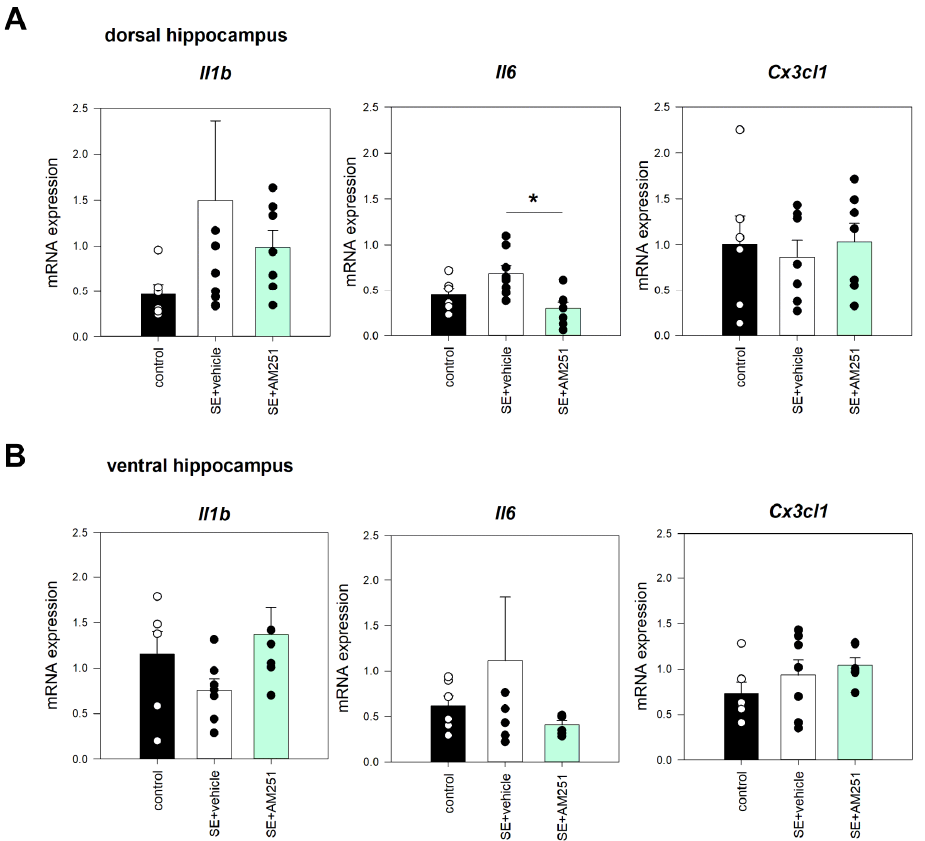
Figure 6. Il1b , Cx3cl1 , and Il6 mRNA expression in the dorsal ( A ) and ventral ( B ) hippocampus 5 months after SE in rats with no SE (control), vehicle-treated treated rats (SE + vehicle), and AM251- treated rats (SE + AM251). Data are presented as mean ± SEM; dots represent individual values for each rat. *—statistically signi fi cant di ff erences at p < 0.05, ANOVA, post hoc.